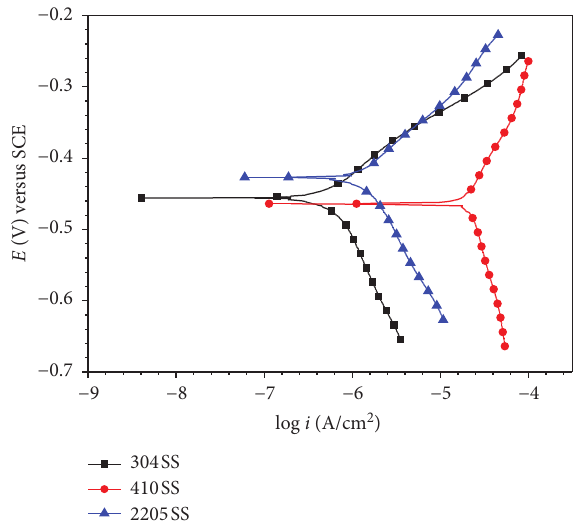
Figure 8: Potentiodynamic polarization curves of 3 stainless steel types after 7-day incubation. Table 6: Tafel parameters fitted from potentiodynamic polarization curves after 7